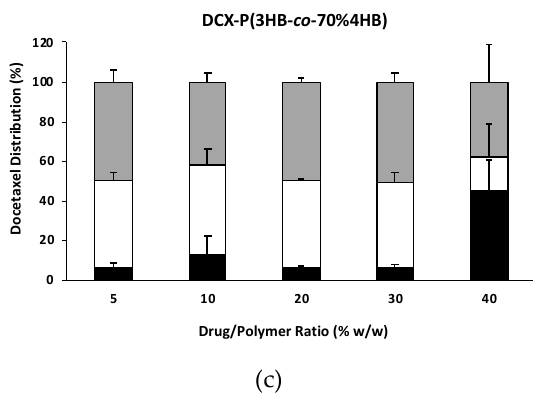
Figure 3. Docetaxel distribution, expressed as percentage of drug precipitated or in agglomerates (black bars), in solution (white bars) and encapsulated in nanoparticles (grey bars) in relation to the total drug recovered, determined for ( a ) DCX-PHB16, ( b ) DCX-PHB30 and ( c ) DCX-PHB70 nanoparticles.